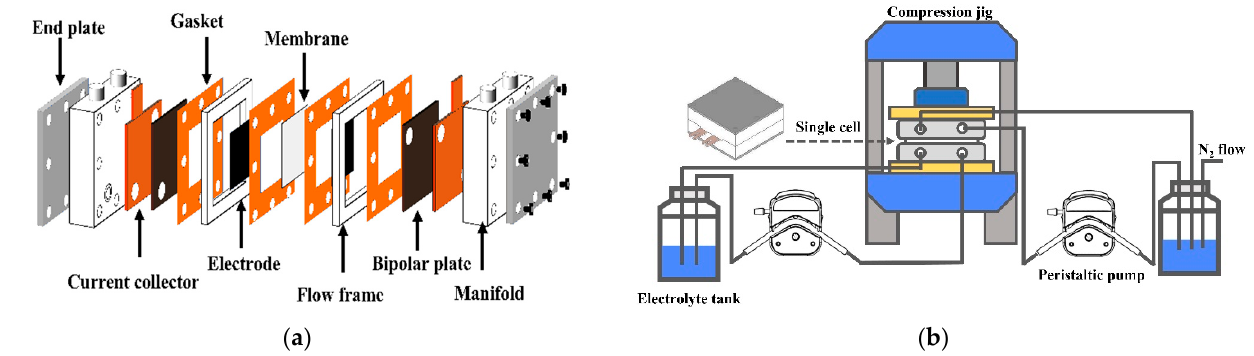
Figure 2. ( a ) Diagrammatic assembly drawings of our in-house VRFB cell and ( b ) the VRFB system installation. Table 1. The specifications of the VRFB single cell .